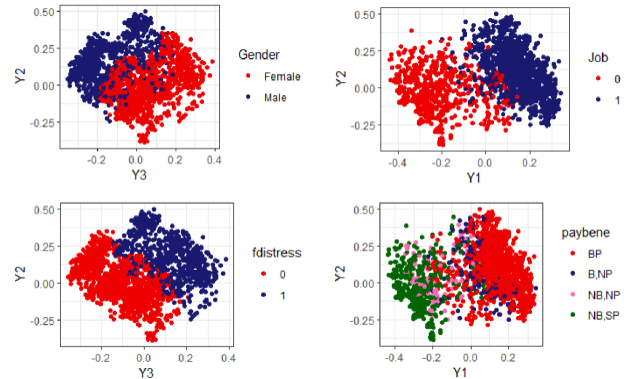
Figure 3. MDS representation. Influential